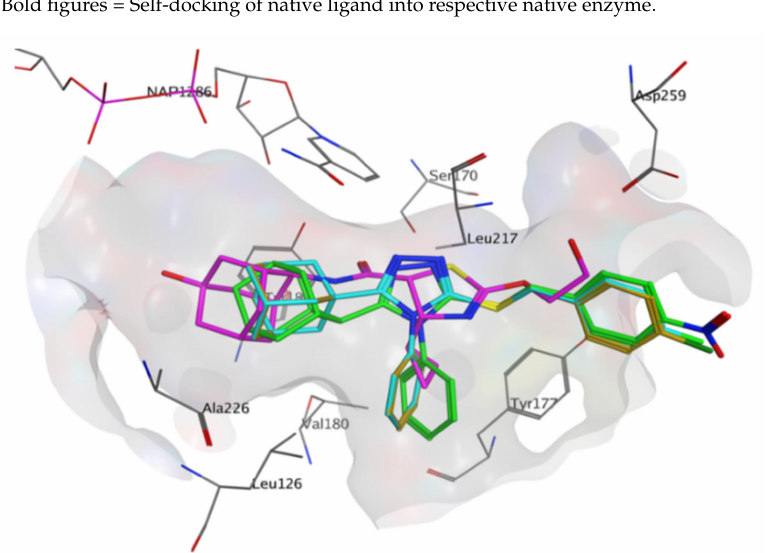
Bold figures = Self-docking of native ligand into respective native enzyme.